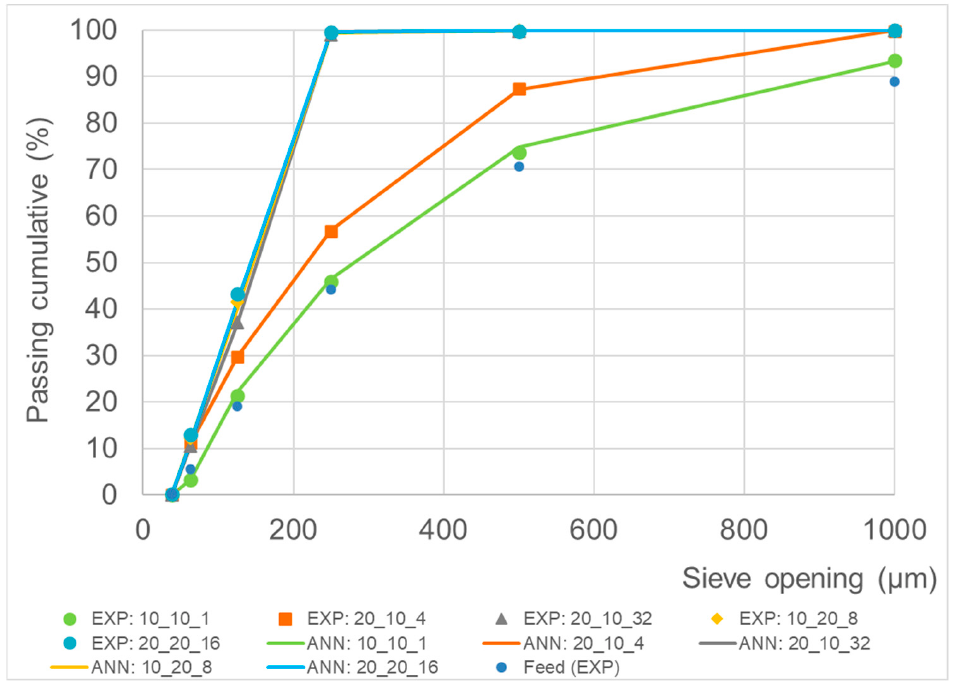
Figure 6. Comparisons between the ANN-predicted PPC (ANN) and experimental PPC (EXP). The numbers in the figure legend represent FL (Vol.%), RL (Vol.%), and GT (Min.). The feed (EXP) particle size distribution without grinding (GT = 0 min) was also added as a reference value.